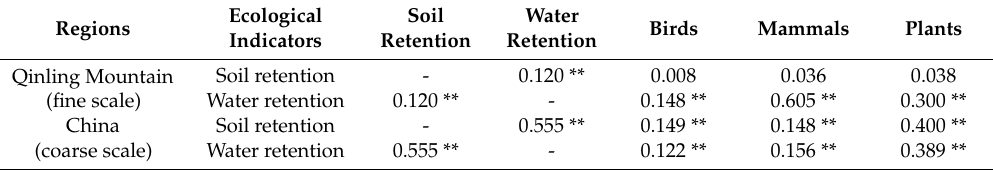
Table 1. Correlation coefficients of species richness and regulating ecosystem services in two case areas. Regions